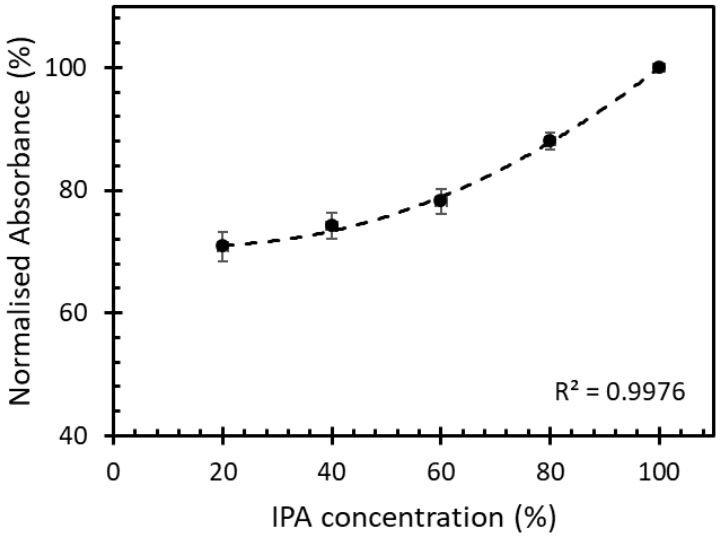
Figure 6. Normalized absorbance of IPA vapor in free space with different concentrations at a fixed